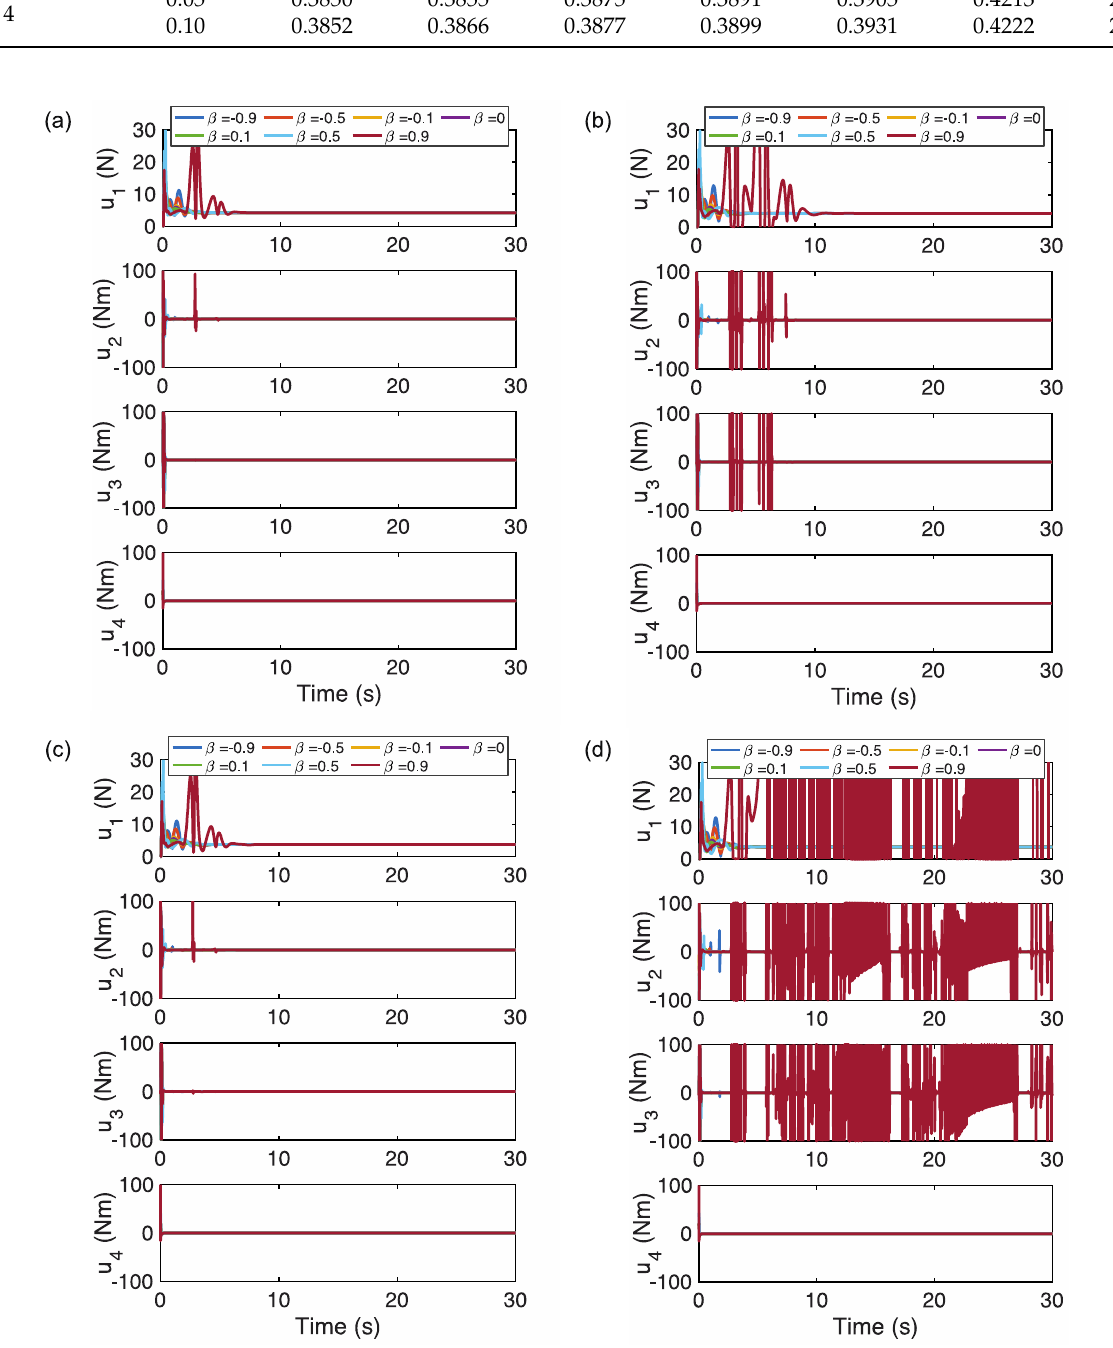
Figure 8. Simulated control inputs of the varying fractional orders in the proposed controller to uncertainty in the quadrotor dynamics with various payloads and uncertain input time delays: ( a ) d = 2 m/s 2 and 𝜏 = 0.05 s, ( b ) 𝑑 = 2 m/s 2 and 𝜏 = 0.10 s, ( c ) 𝑑 = 4 m/s 2 and 𝜏 = 0.05 s, ( d ) 𝑑 (cid:2871) (cid:2871) (cid:2871) 𝑑 = 4 m/s 2 and 𝜏 = 0.10 s. (Assume that 𝑑 = 𝑑 = 𝑑 = 𝑑 = 𝑑 = 0 and 𝜏 = 𝜏 = 𝜏 = 𝜏 = 𝜏 (cid:2871) (cid:2869) (cid:2870) (cid:2872) (cid:2873) (cid:2874) (cid:2869) (cid:2870) (cid:2871) (cid:2872) .) Table 14. Root mean squared value of the control signal 𝑢 (cid:2869) in the first 30 s under different payloads, different input time delays and different fractional orders in the proposed controller.